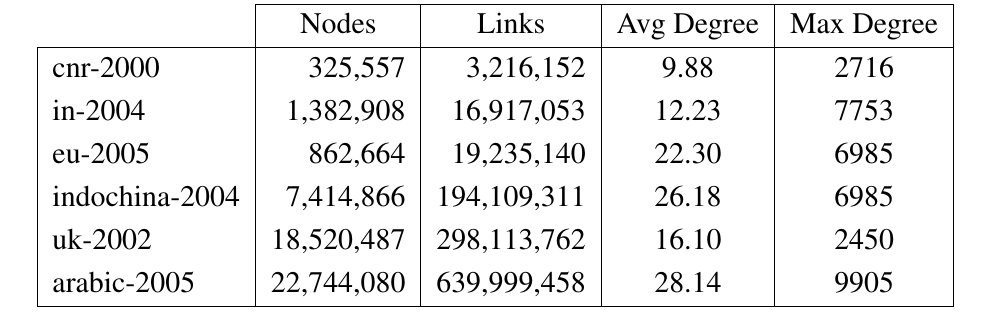
Table 7. Statistics of datasets used for tests.